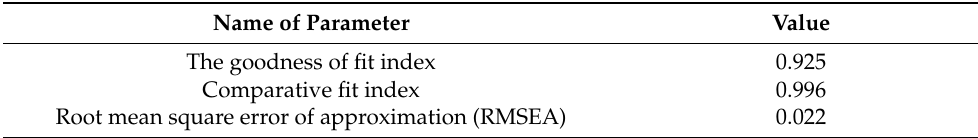
Table 5. Parameter value for model fit measures with SPSS Amos.